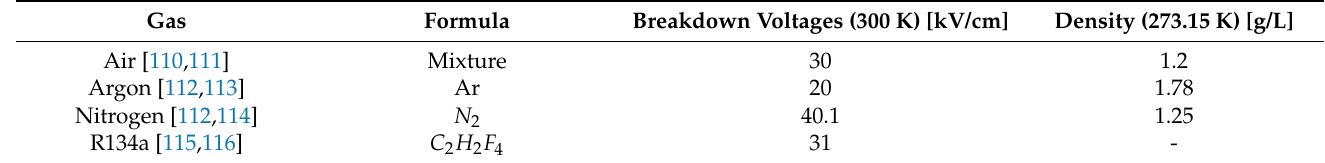
Table 6. Some dielectric gas properties (Atmospheric pressure).